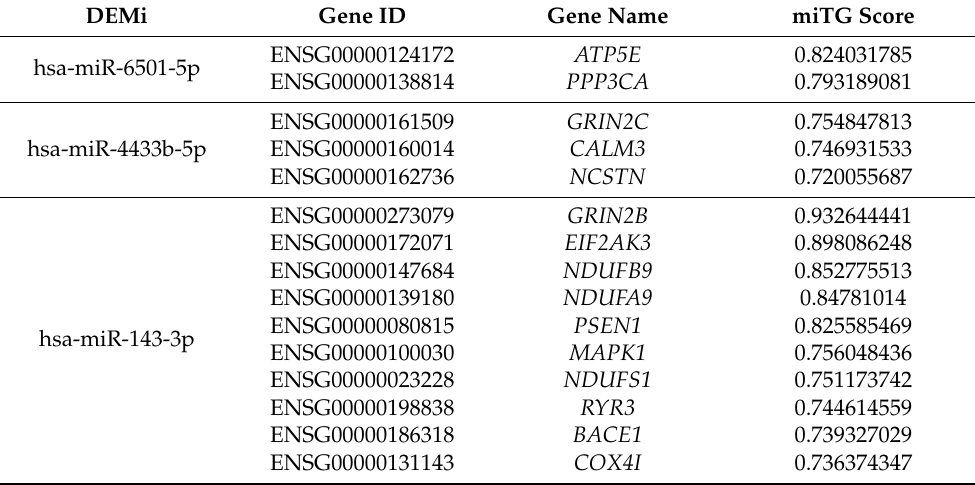
Table 2. DEMis and the predicted target genes related to AD.